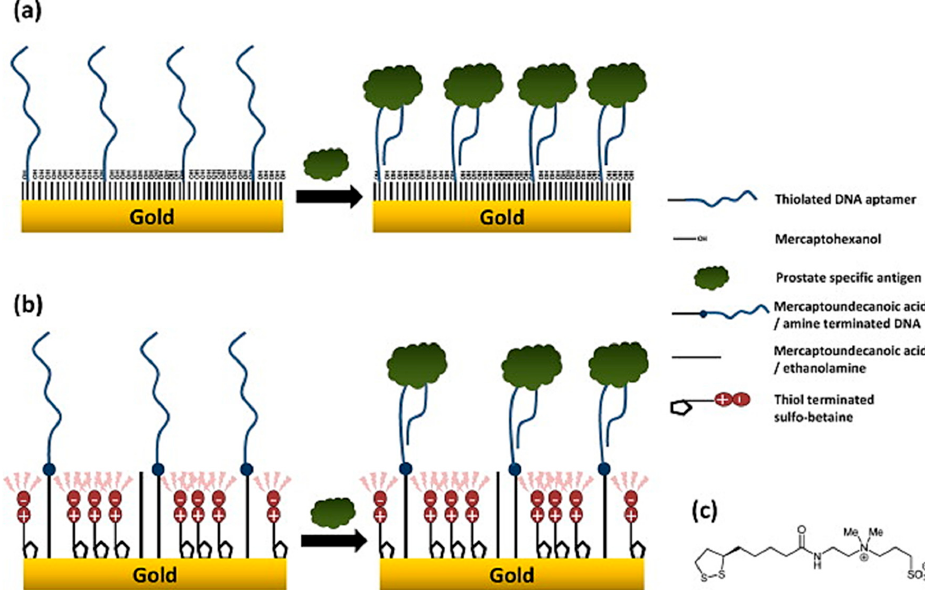
Figure 5. Self-assembled monolayers (SAMs) with DNA aptamers on a gold surface before and after incubation with PSA. ( a ) Thiolated aptamer with MCH; ( b ) amine-terminated aptamer with sulfo-betaine; ( c ) structure of the thiol-modified sulfo-betaine. (Re-printed from Jolly et al. [79]. Copyright (2015), with permission from